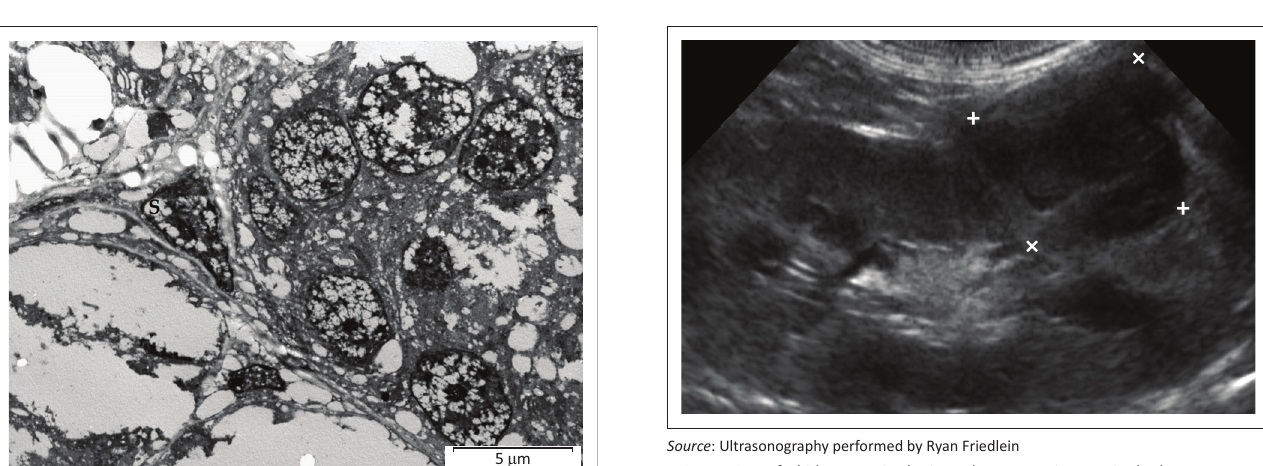
FIGURE 9: Left kidney sagittal view demonstrating a single heterogenous, hypoechoic nodule in the caudoventral aspect that measures 1.8 cm × 1.7 cm (between markers).